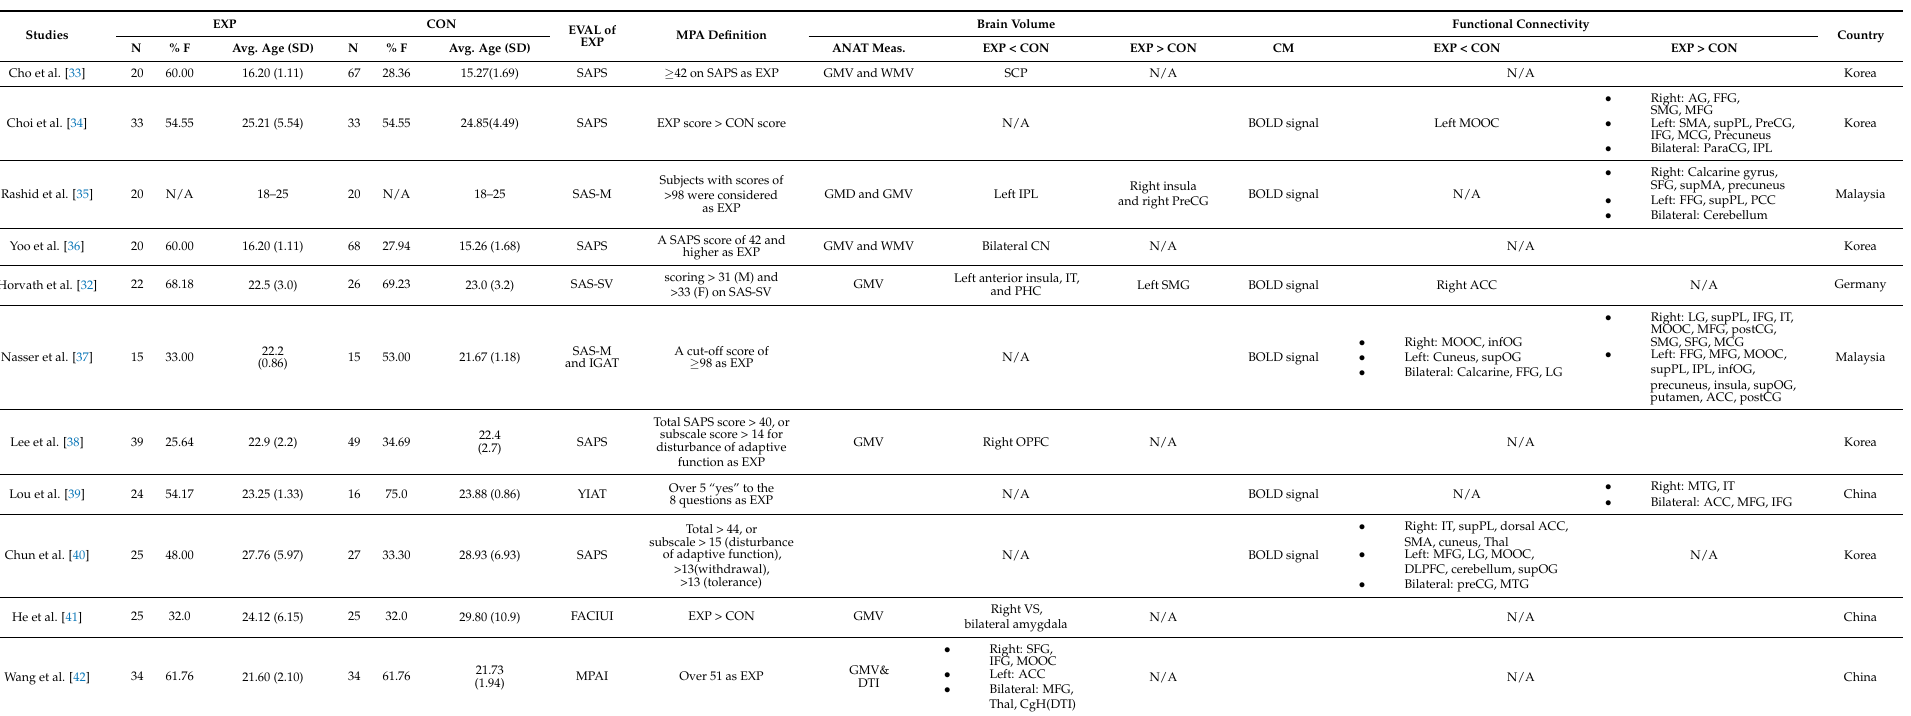
Table 1. Comparison of structural and functional neural correlates between individuals with excessive smartphone use and their counterparts with regular